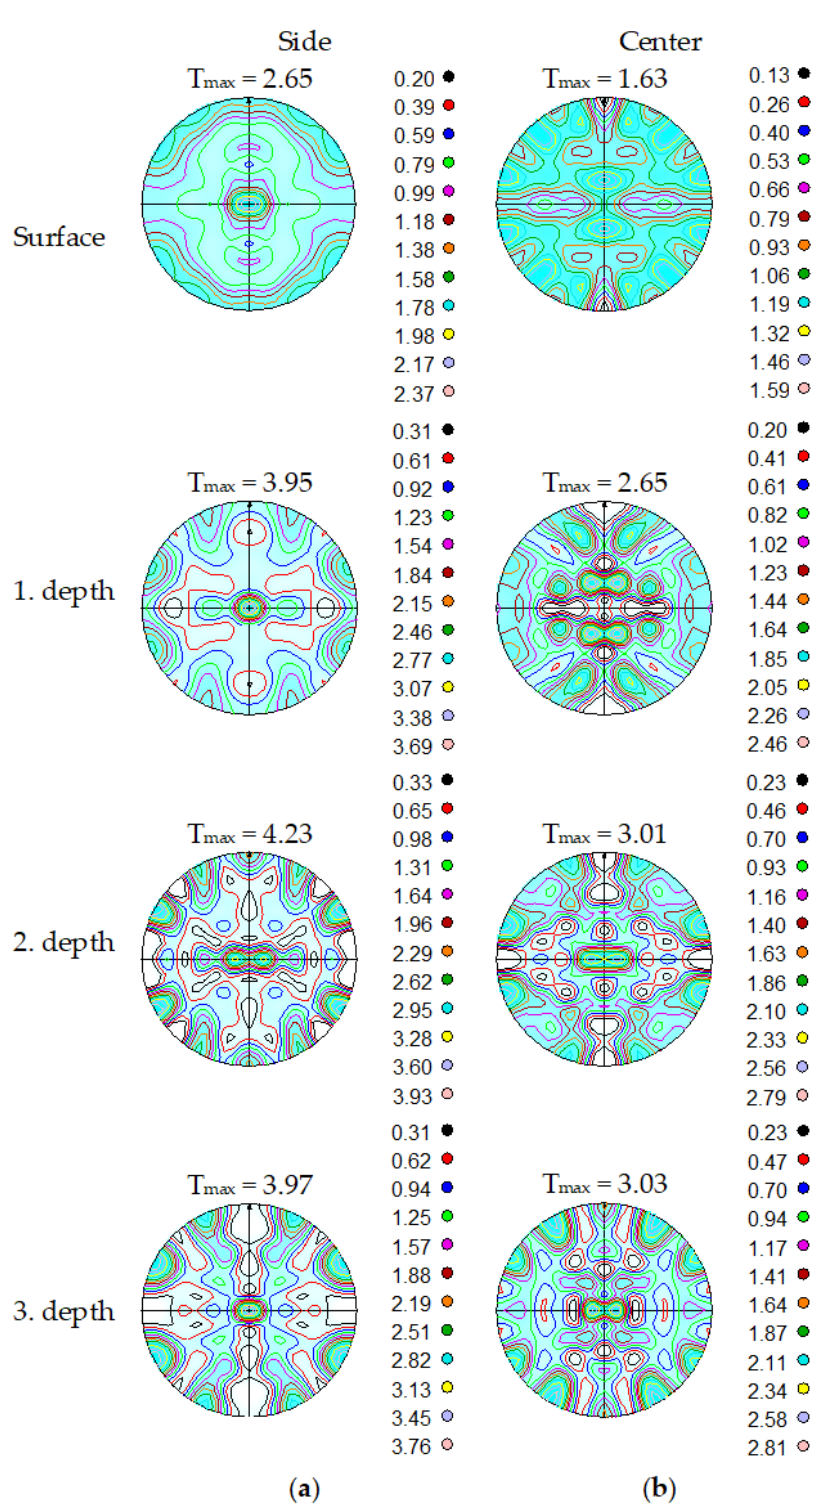
Figure 6. Recalculated full {200} pole figures taken from different depths. ( a ) Sample from the side and ( b ) from the center of the hot-rolled